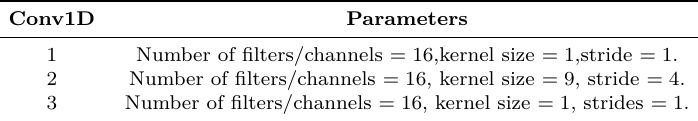
Table 1: Parameters of each layers in TTSCA small .